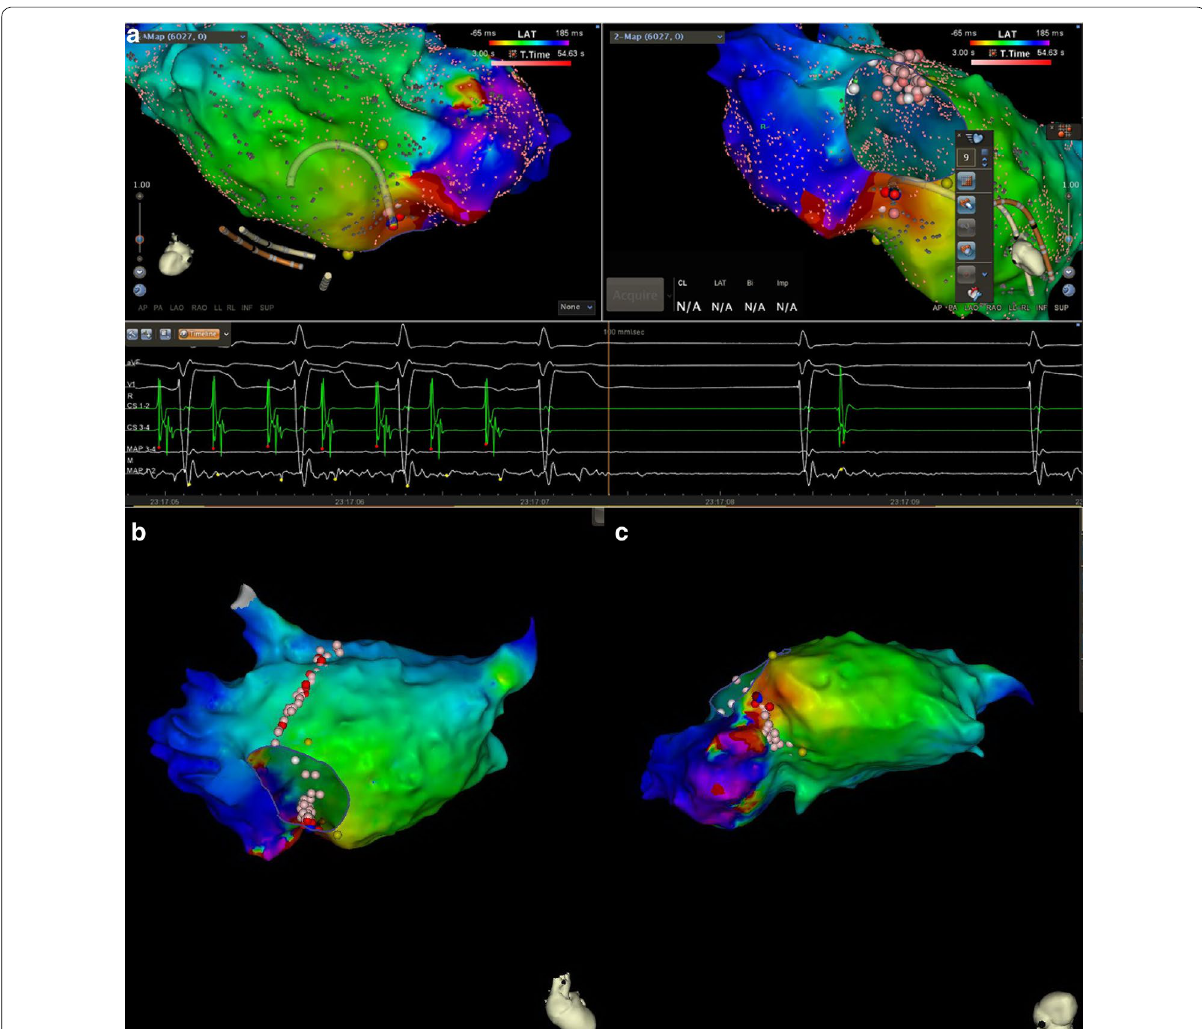
Fig. 4 Complete ablation lines. a Atrial flutter was terminated when second ablation line from inferior endocardium of left atrial appendage to 6’ clock of morphological tricuspid annulus accomplished. b The first ablation line. c The second ablation